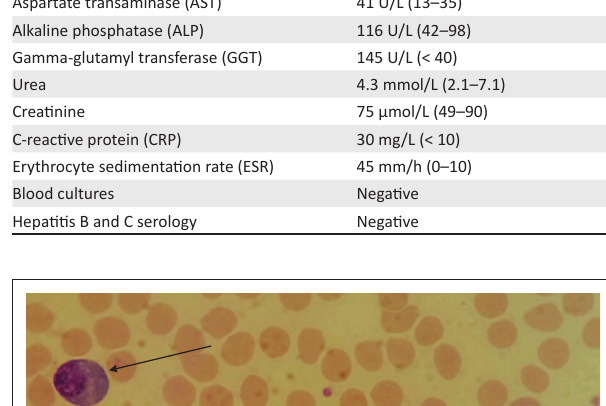
FIGURE 2: Immunophenotypic analysis of the peripheral blood performed on a dual laser FACSCalibur equipped with CellQuest Pro and PAINT-A-Gate Pro software. CD19 is the monoclonal antibody on FITC and CD138 is the monoclonal antibody on PE. There is a population of ~20 % – 25 % plasma cells (yellow) which express a range of CD138 and CD19, and a population of ~20 % B-cells (red) as defined by CD19 expression only.